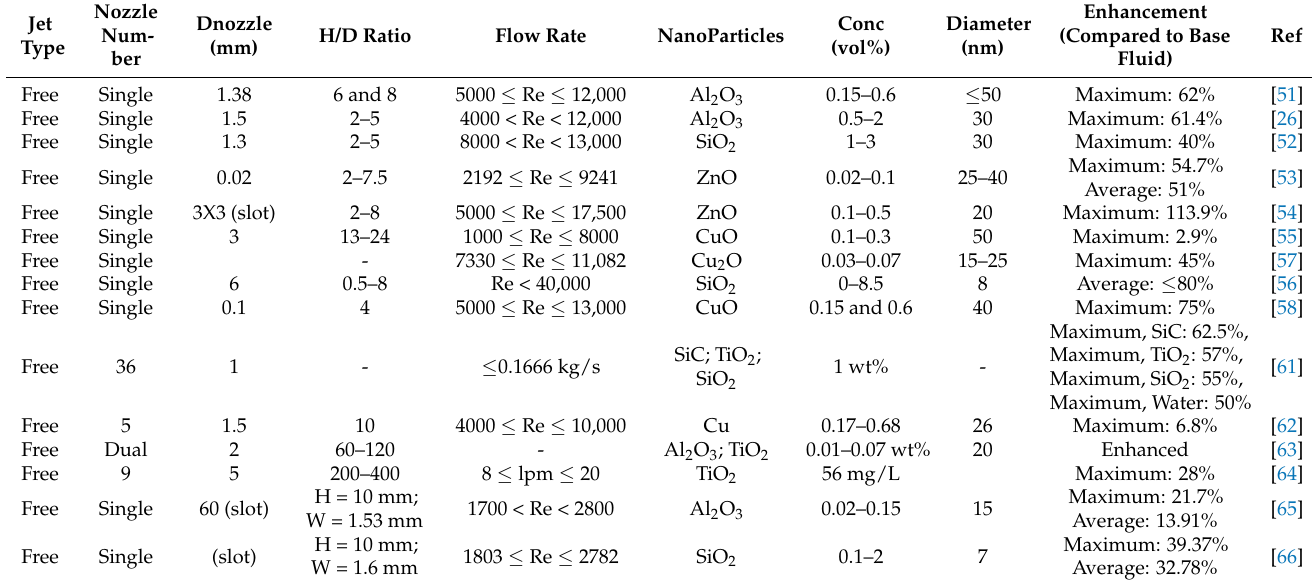
Table 5. Summary of past experimental studies on conventional impinging